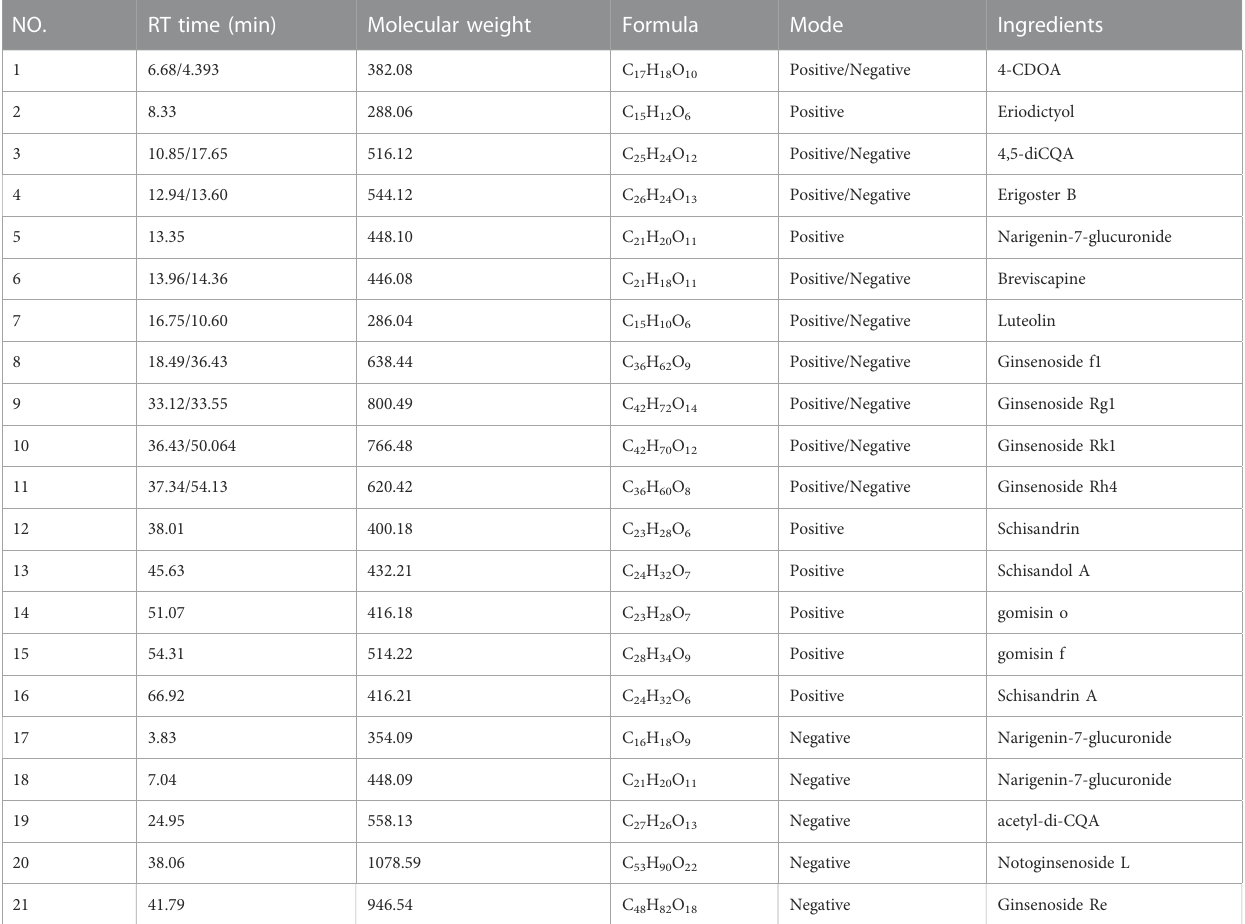
TABLE 1 Results of UPLC-MS/MS analysis of